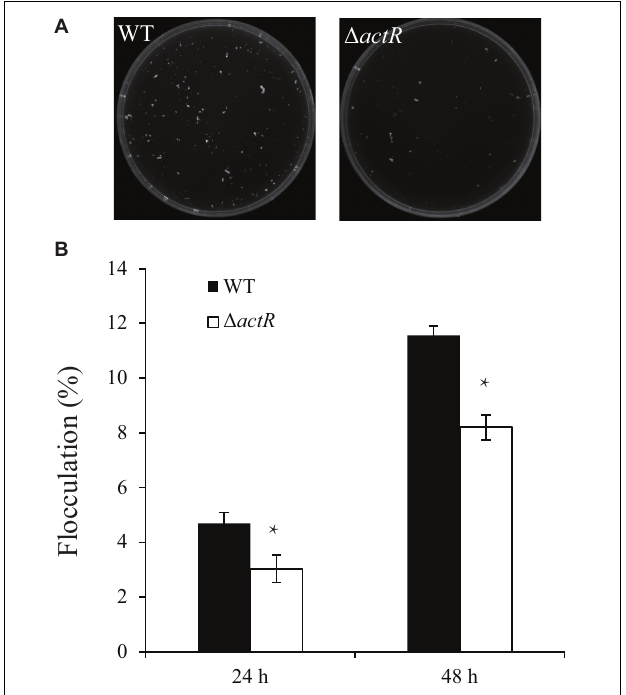
FIGURE 5 | Effect of ActR on the flocculation generated by wild-type (WT) and mutant strains. (A) Representative images of flocculation morphologies produced by the WT and (cid:49) actR mutant. Strains were inoculated with L3+1/2N liquid medium, and photographs were taken after 48 h of incubation. (B) Quantitative analysis of the flocculation cell mass. Bar plot represents the mean and SD of the percent density of flocculation generated by each strain. Means and SDs were obtained from at least three independent experiments. Student’s t -test; *represents significant difference at p < 0.05.